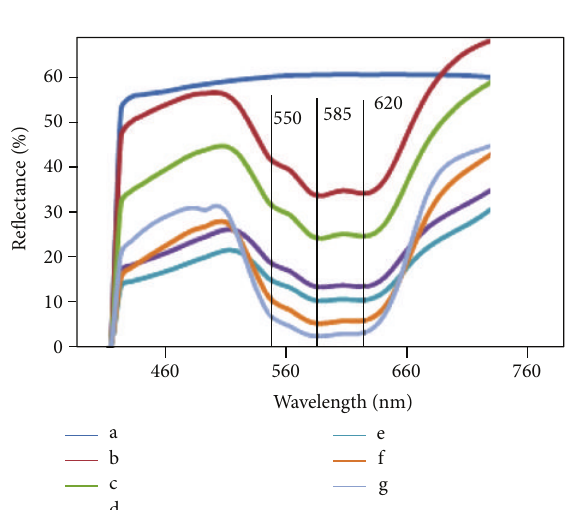
Mg 1− Al O ( x = 0, 0.1, 0.2, 0.4, x x 2 4